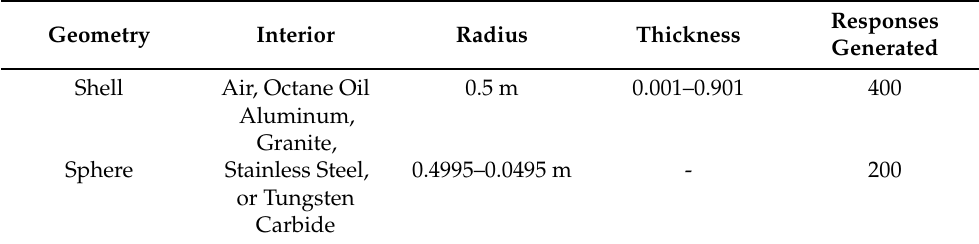
Table 3. Target properties used for simulating backscattered